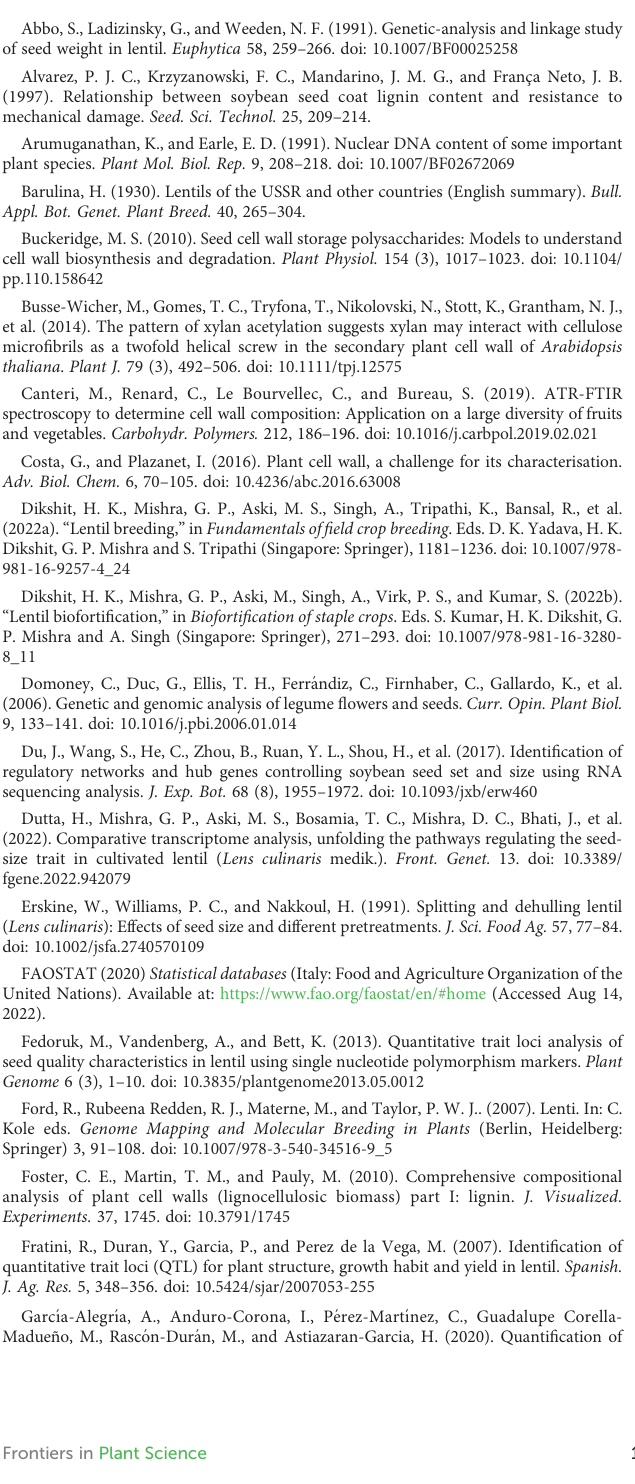
SUPPLEMENTARY FIGURE 6 Sequnce similarity of the marker (PBALC449) with the relative sp. It is showing most similarity to Medicago truncatula , followed by Cicer arietinum . SUPPLEMENTARY FIGURE 7 Representative image of eight lentil RIL genotypes, captured by VideometerLab 4.0 at two wavelengths (590 and 850 nm) for further seed parameter analysis. SUPPLEMENTARY FIGURE 8 Image of the lentil genotypes (L830 and L4602) captured by VideometerLab 4.0 at 19 wavelengths (375 to 970 nm) for further seed parameter